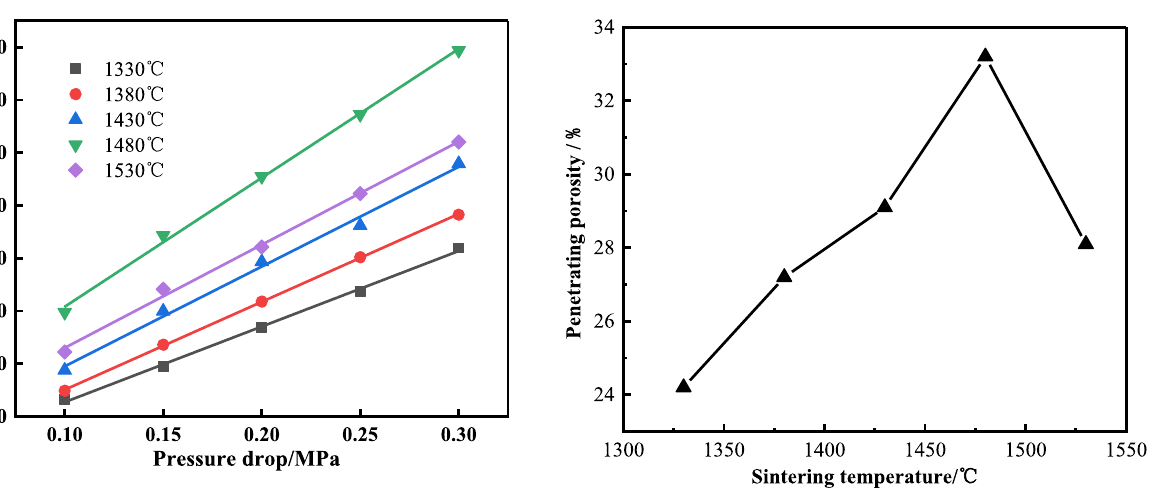
Fig. 9 Penetrating porosity of support samples SM sintered at various temperatures in an air atmosphere for 2